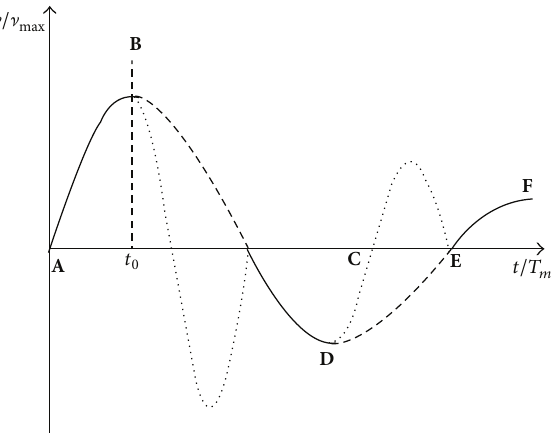
Figure 4: Response of the main mass 𝑚 − Δ𝑚 before the stiffness reduction (–) and after the reduction (--). The dotted line represents the response of the secondary system when disconnected. Response is normalized to the maximum value, and time is normalized considering the mean period 𝑇 𝑚 = (𝑇 on + 𝑇 off )/2